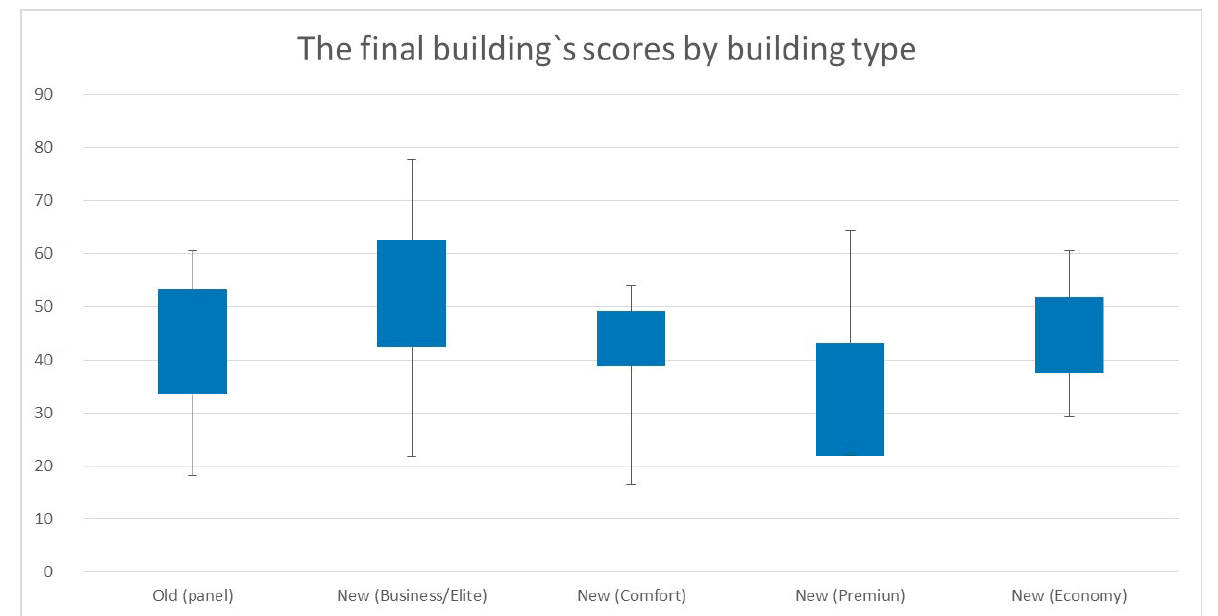
Figure 3. The average scores for each category.